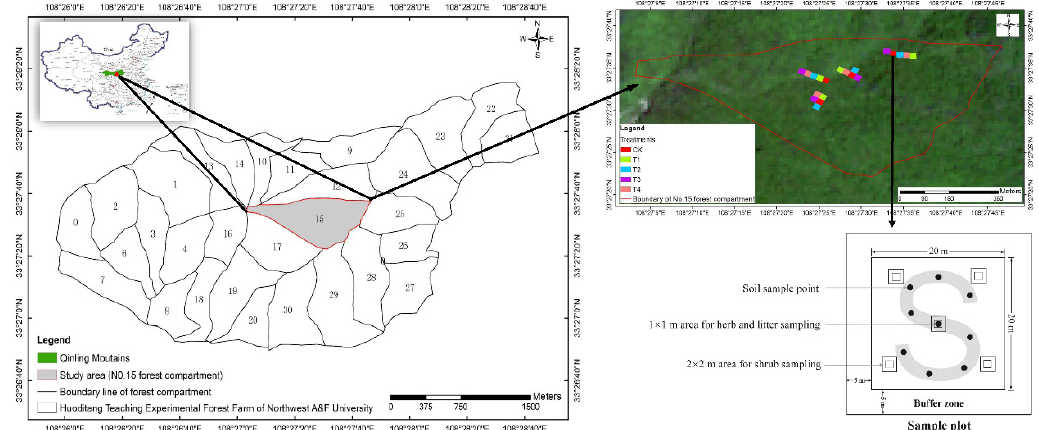
Figure 1. Location of the study area and the layout of the experimental plots. CK, T1, T2, T3, and T4 represent 0%, 15%, 30%, 45% and 60% thinning intensities, respectively.